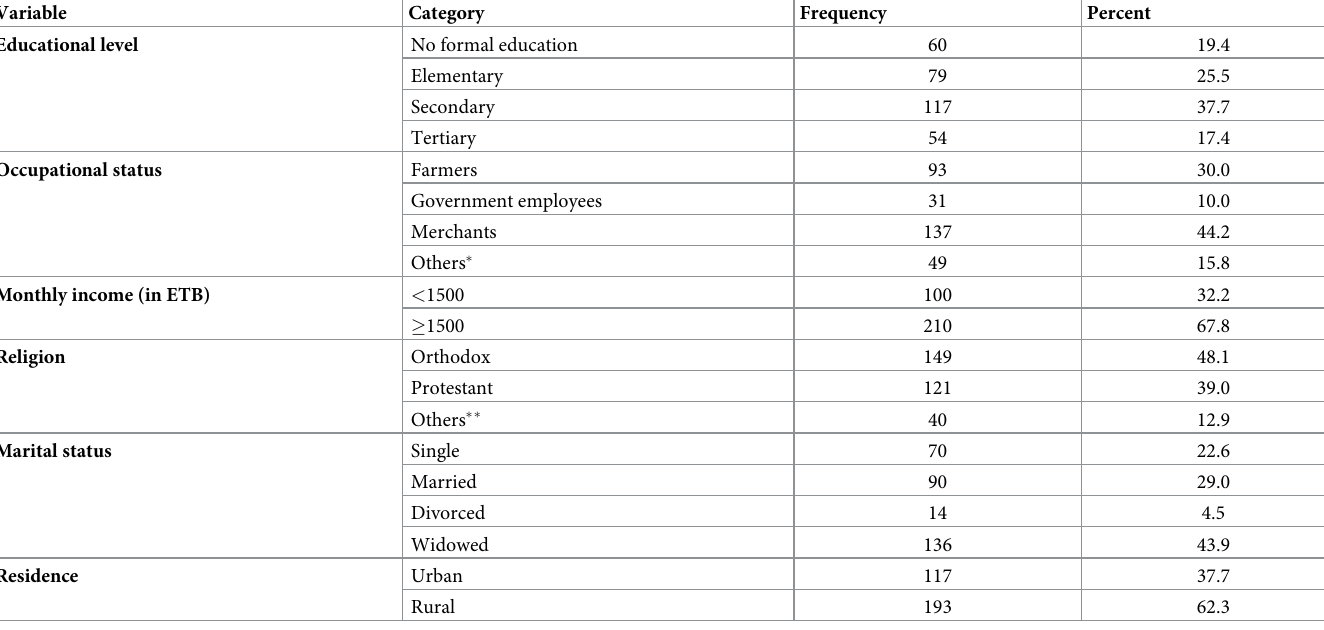
Table 1. Socio-demographic characteristics of participants on first-line ART at public health facilities of North Shewa Zone, Amhara Regional State, Ethiopia, 2019. Variable Category Educational